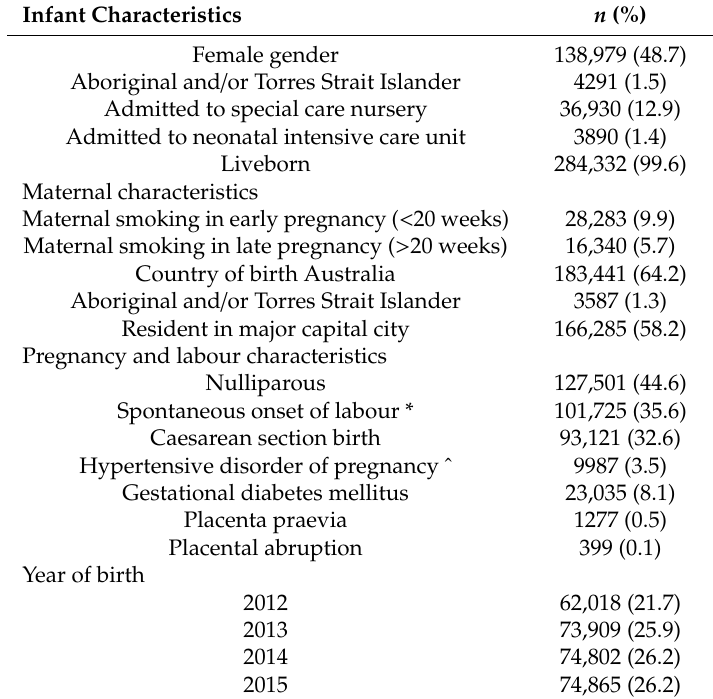
Table 1. Description of all singleton births in Victoria 1 March 2012 to 31 December 2015 ( n =